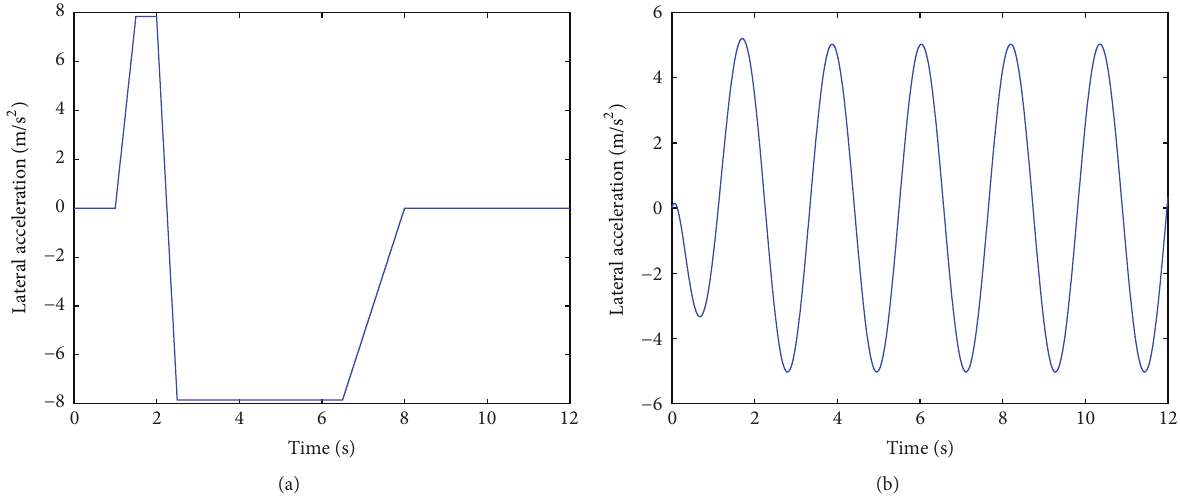
Figure 6: (a) Equivalent lateral acceleration of the fishhook maneuver. (b) Equivalent lateral acceleration of the slalom test.